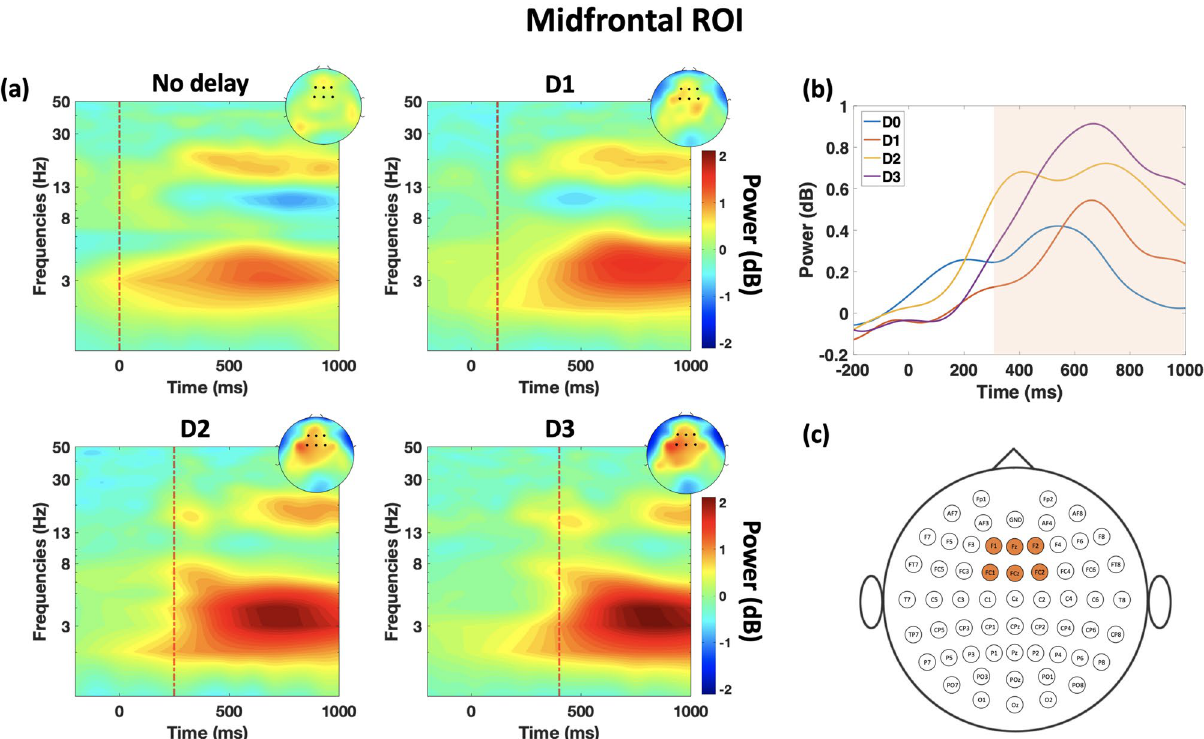
Figure 4. Time–frequency representation of theta band correlates at the midfrontal ROI ( a ) ERSP dynamics of the EEG data in the midfrontal ROI averaged over trials and subjects per condition. The dashed red line shows the event of the haptic feedback disable. Topography plots are obtained by averaging power in the window of 400–900 ms where the maximal effect of midfrontal theta is observed. ( b ) Time-course of the theta power under the four delay conditions. Highlighted region signifies the time interval during which a statistically significant difference is found between the four conditions ( p ≤ 0.05, randomization-based ANOVA test, FDR corrected; t range = [300–1000 ms]). ( c ) Channels included in the theta band analysis at the midfrontal